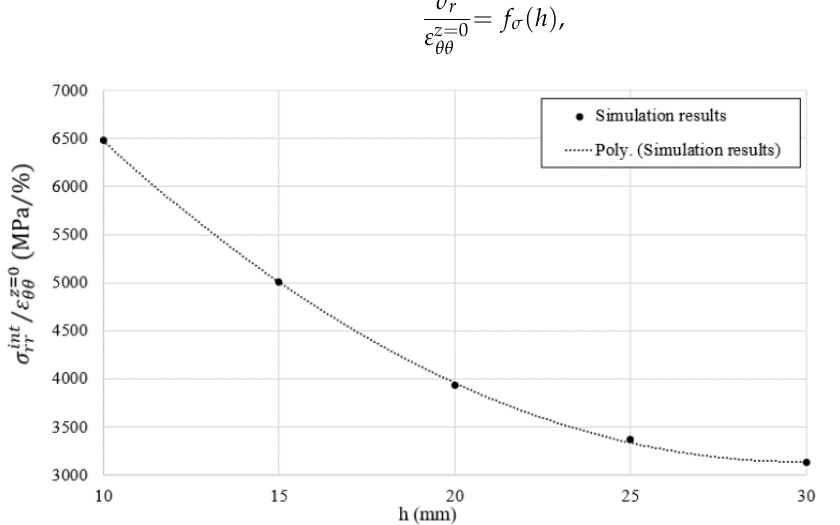
Figure 4. Axisymmetric numerical simulations of the elastic ring loaded as described in Figure 3: ( a ) Hoop strain; ( b ) Von Mises criterion.